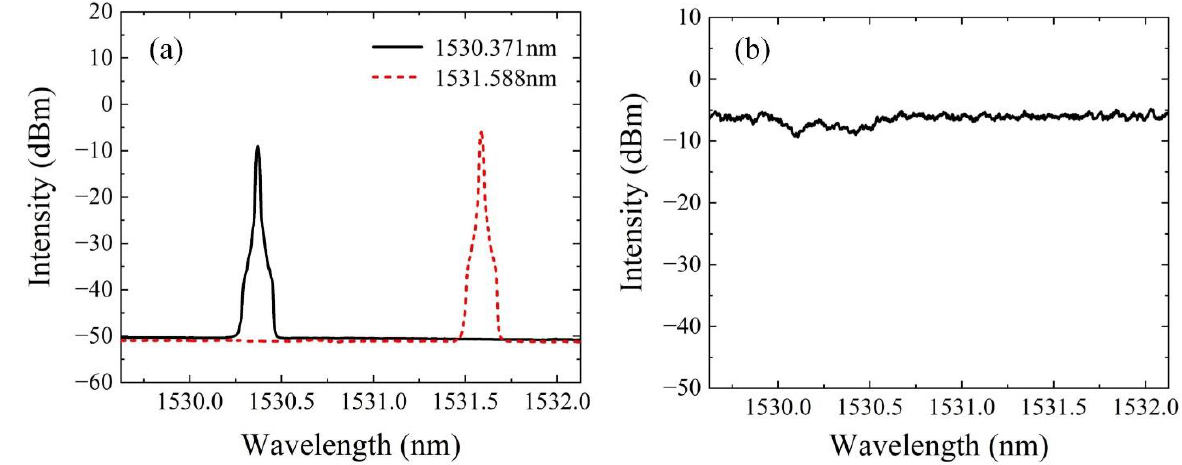
Figure 5. The laser output spectra without acetylene